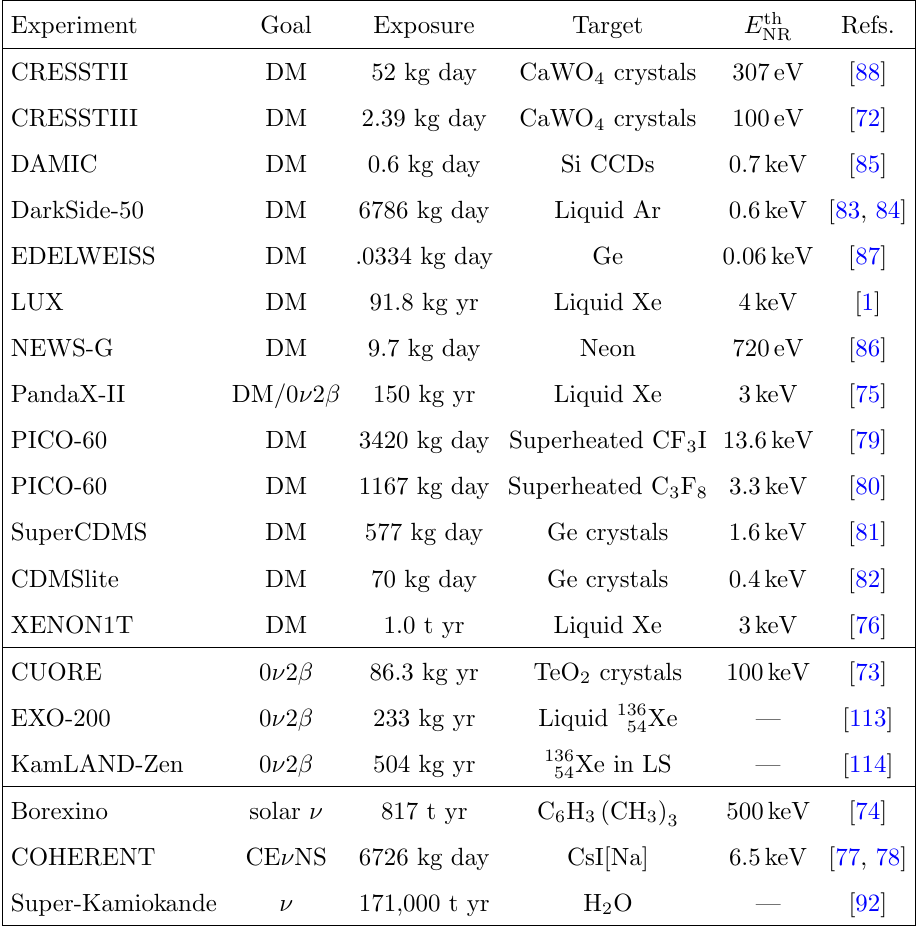
Table 3 . Experiments which can probe fermionic dark matter absorption signals for which we show projected sensitivities in (cid:12)gures 4, 6, and 7. Experiments without an explicit nuclear recoil threshold, E th , are not used for neutral current NR